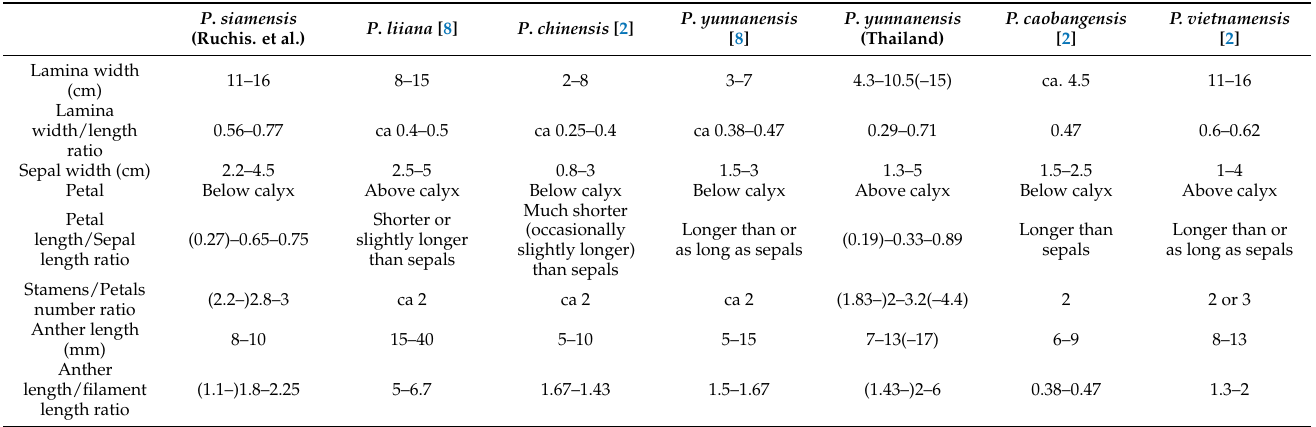
Table 1. Comparison of the morphology of P. siamensis and related